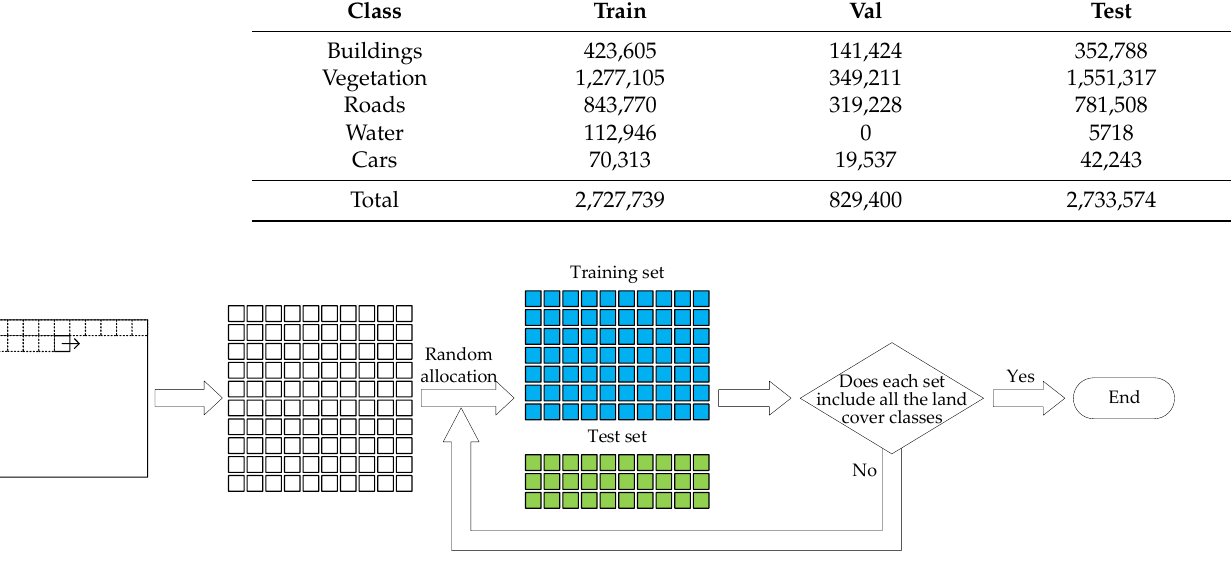
Figure 4. Dataset partition method. Table 2. Number of samples in train and test sets for the DFC2018 datasets.